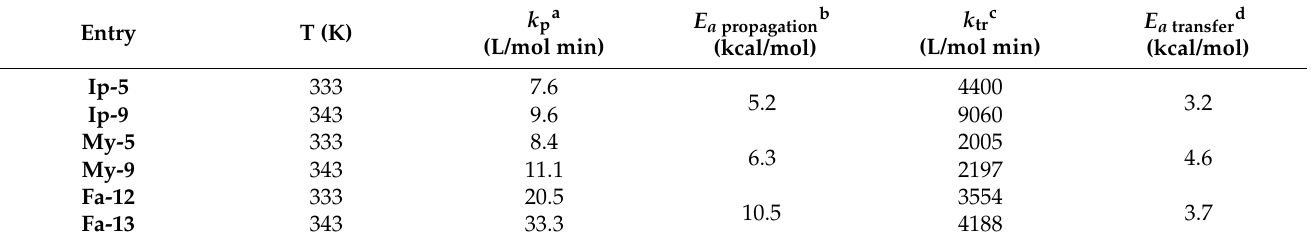
Figure 5. Effect of temperature on the reaction rate for ( a ) Ip: entries Ip-5 and Ip9, ( b ) My: entries My-5 and My-9 and ( c ) Fa: entries Fa-12 and Fa-13 polymerizations initiated by NdV 3 /Al( i - Bu) 2 H/Me 2 SiCl 2 in cyclohexane. Table 5. Effect of temperature on the propagation and chain transfer